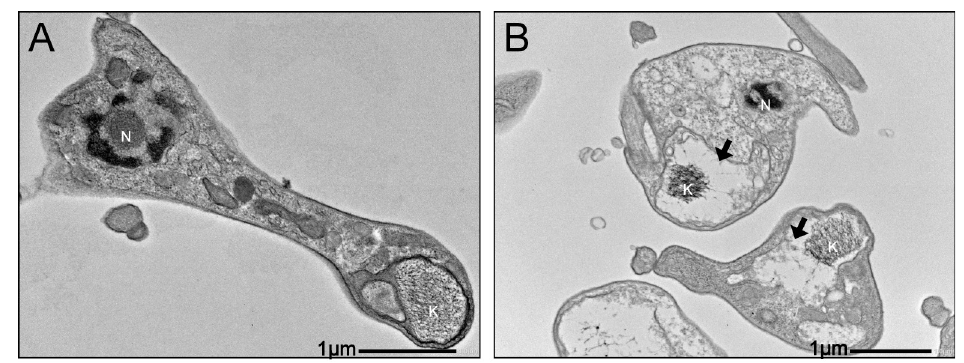
Fig 4. Transmission electron micrographs showing the ultrastructure of trypomastigotes. Nucleus (N); kinetoplast (K); swollen mitochondria (Black arrow). A: Control untreated; B: Treatment with isoobtusilactone A (LC 50 ) for 2 hours.